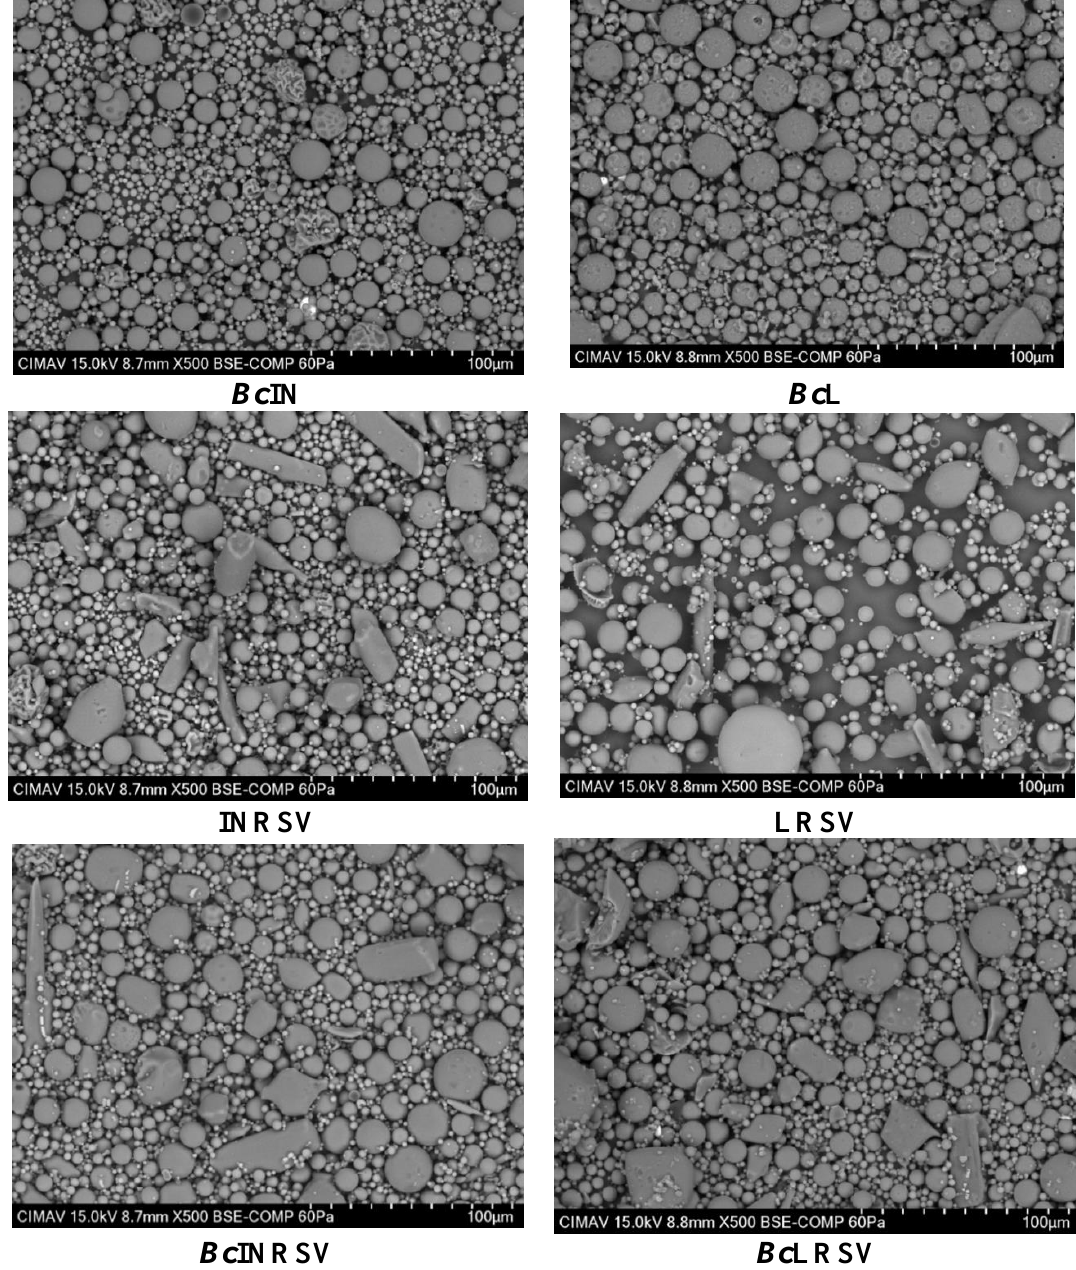
Figure 5. SEM micrographs of powders: microencapsulated B. clausii ( Bc IN, Bc L), resveratrol (INRSV, LRSV), and co-microencapsulated ( Bc INRSV, Bc LRSV).